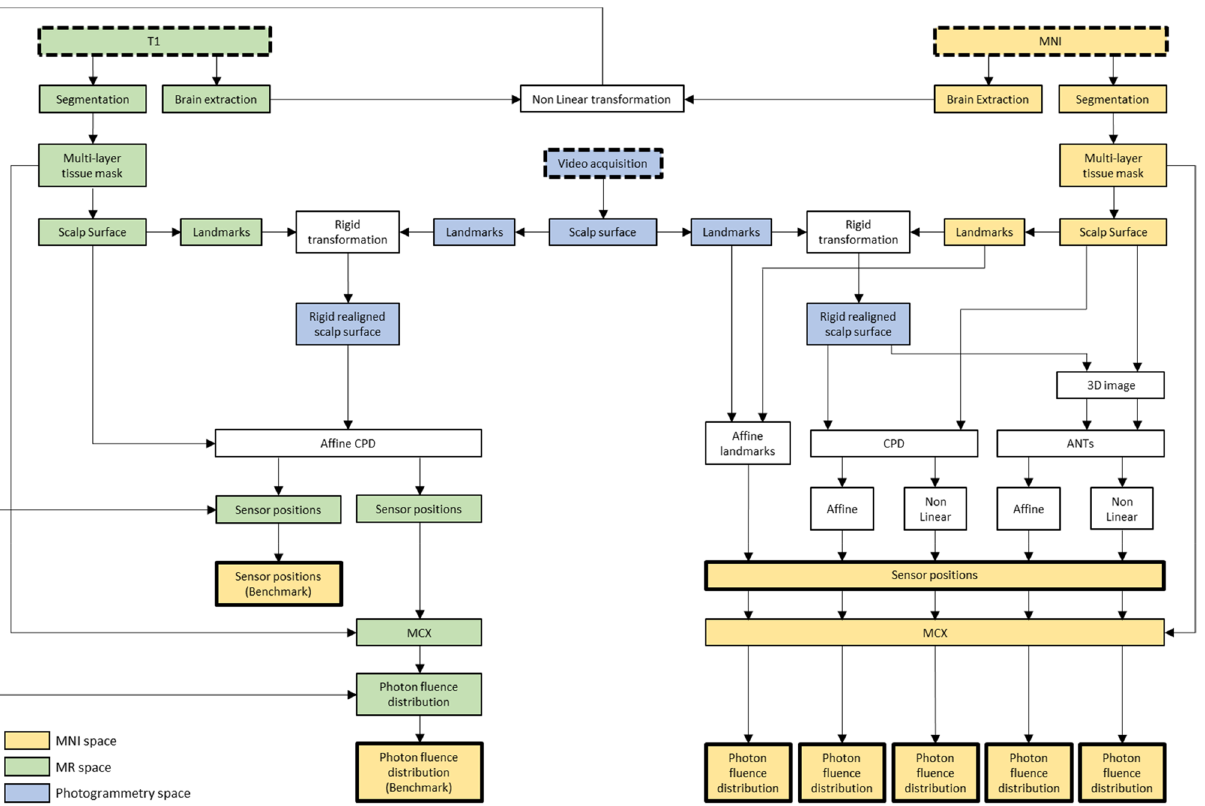
Figure 2. Schematic of the workflow of the registration study. Dashed boxes highlight the data required to perform the analyses, whereas the thicker boxes identify the final outputs, which were then compared to assess the best approach to map the sensor positions from the individual surface to the atlas template